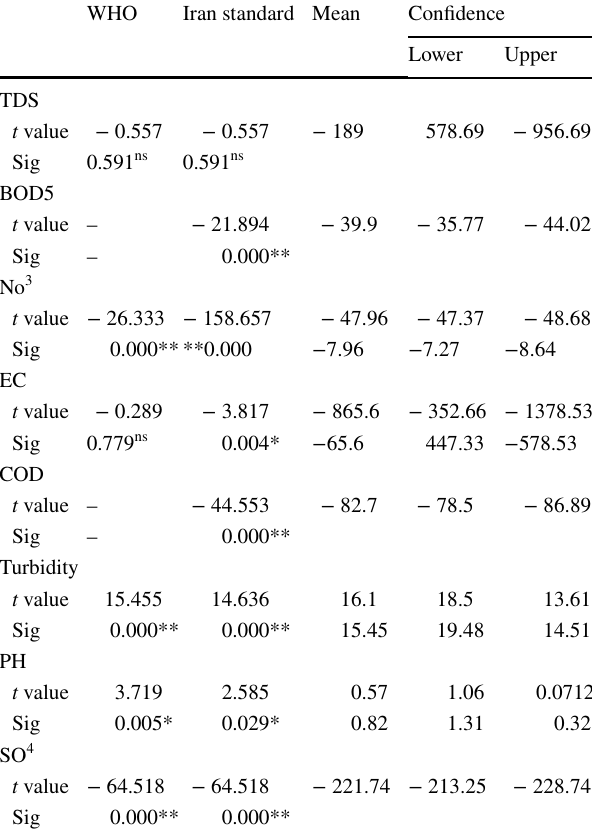
* 5% difference level probability is meaningful. ** The difference in 1% probability is meaningful. ns The mean difference is